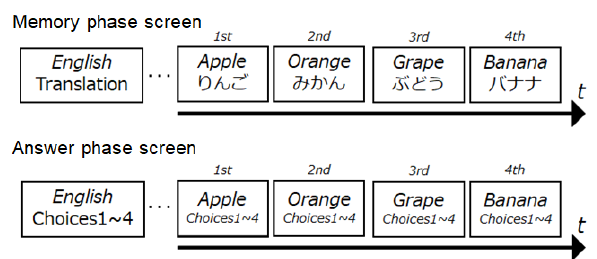
Figure 4. The order of the memorization target in each